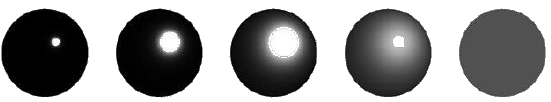
Figure 3. Illustration of the Cook-Torrance surface reflectance for increasing roughness.